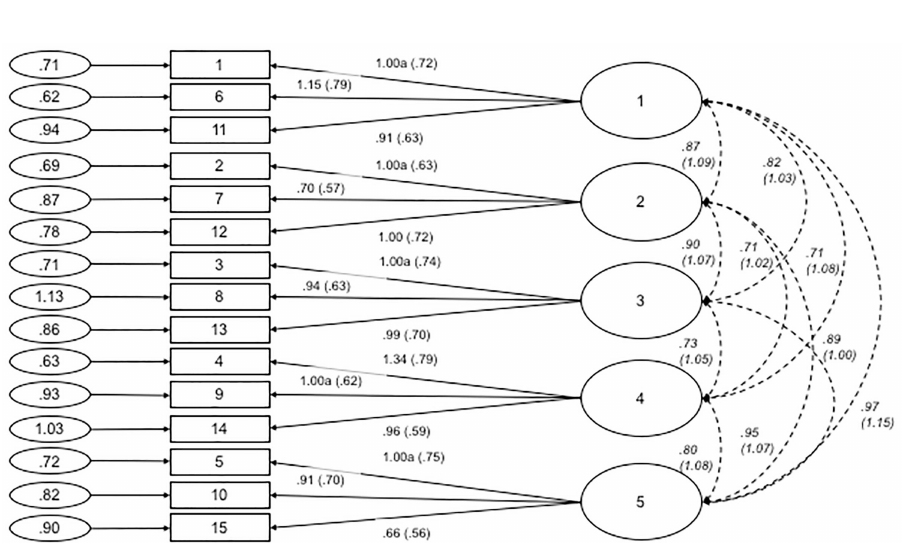
Fig 4. Path diagram and estimatesfor the five-factor Generic Conspiracist Beliefs Scale. Item numbers in the figure reflect the item number in Table 6. The large circles are the latent construct, with the rectangles representing measured variables, and the small circles with numbers are the residualvariables(variances). The factor loadingsare standardised in parenthesises, and the unstandarised values outside, with both being reportedfollowingthe guidelinesof Kline [42]. Significance levels were determinedby critical ratios (all p < .001). Estimates of covariancebetweenexogenous variablesare displayedin italics. The factor loadingswere fixed at the indicatedvalue